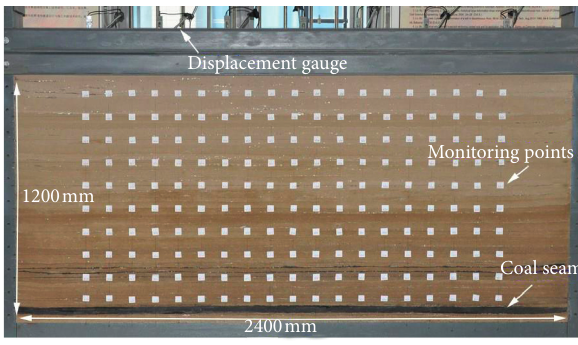
Figure 4: The model before excavation. Table 4: Fracture angle of overburden roof.